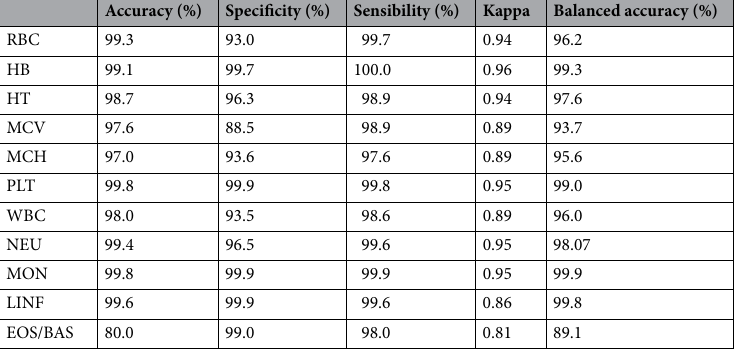
Table 1. Accuracy, specificity, sensibility, kappa coefficient, and balanced accuracy of the method comparison study, comparing the Hilab system to Sysmex XE-2100.